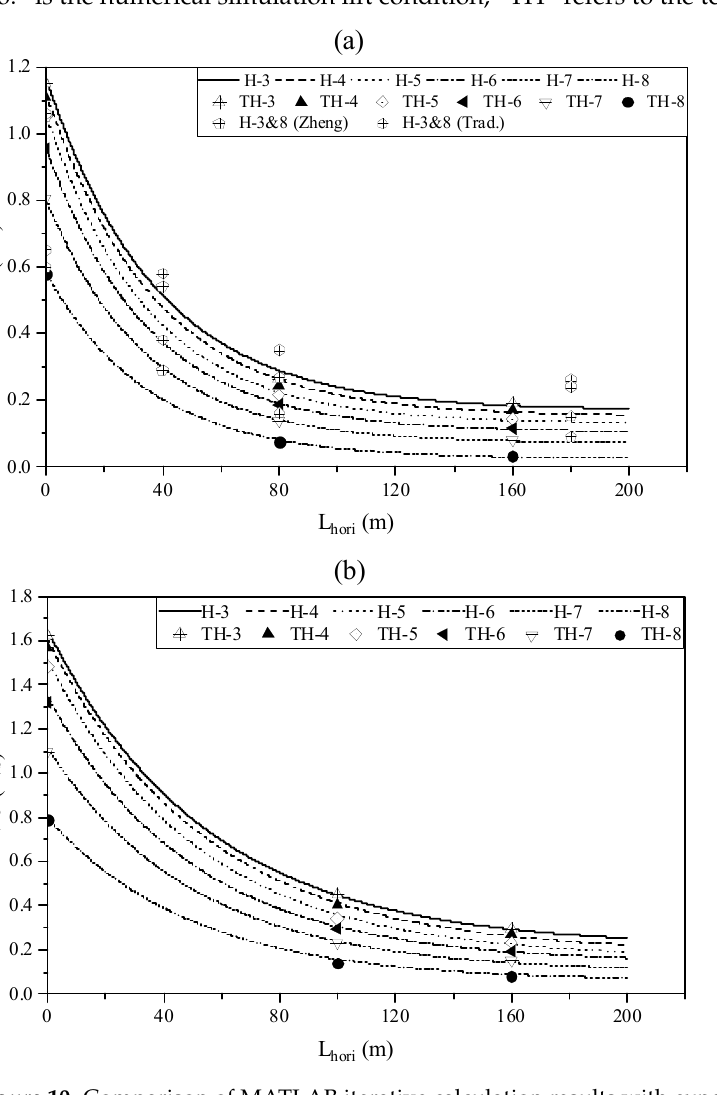
Figure 10. Comparison of MATLAB iterative calculation results with experimental data of siphon flow rate: ( a ) D-4; ( b )